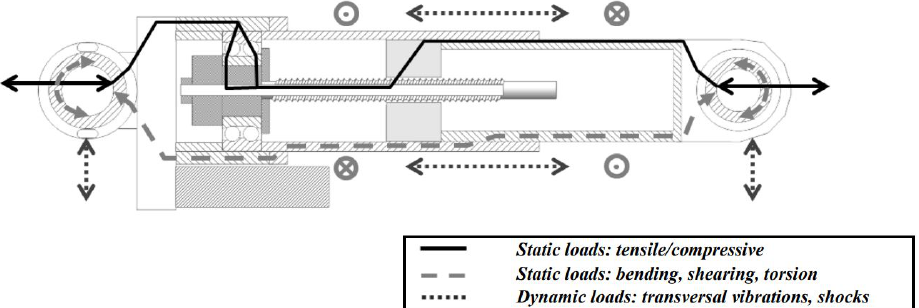
Figure 11. Load path in generic EMA [38].